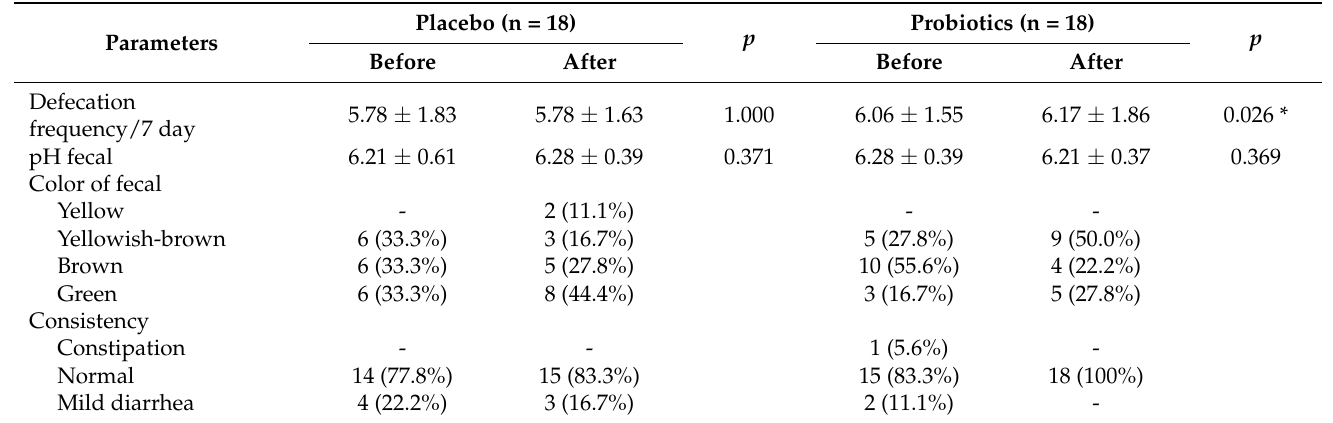
Table 4. Fecal characteristics and defecation frequency.